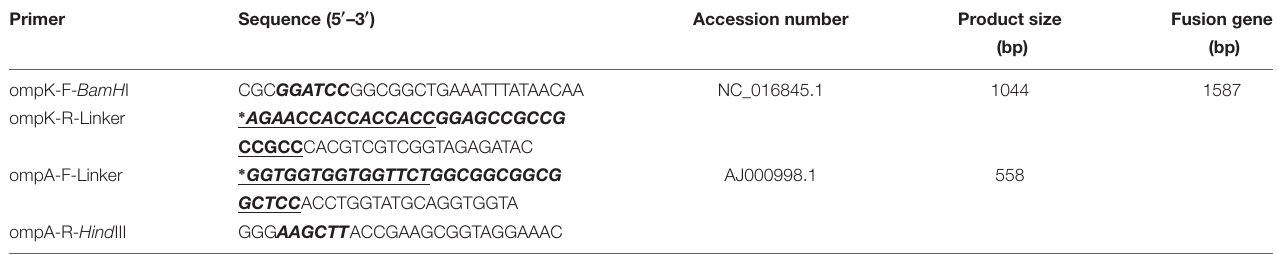
TABLE 1 | List of primers, their sequences and accession numbers used for construction of chimeric rAK36 gene.